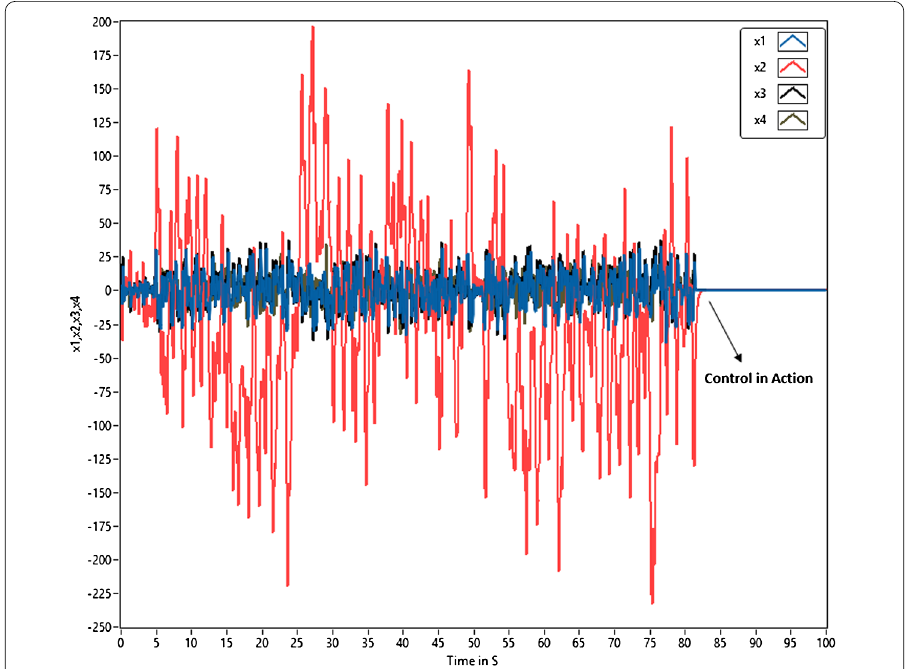
Figure 18 FPGA implemented ASMC controller in action at t =85